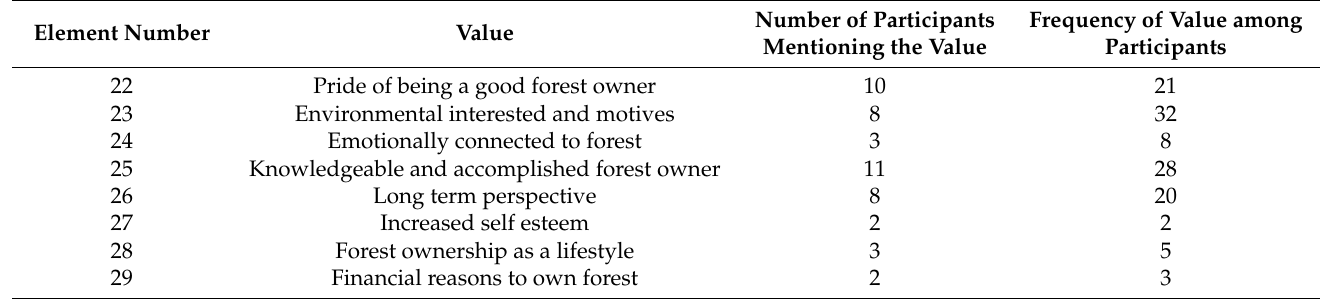
Table 6. Frequency of values mentioned in interviews with participants.